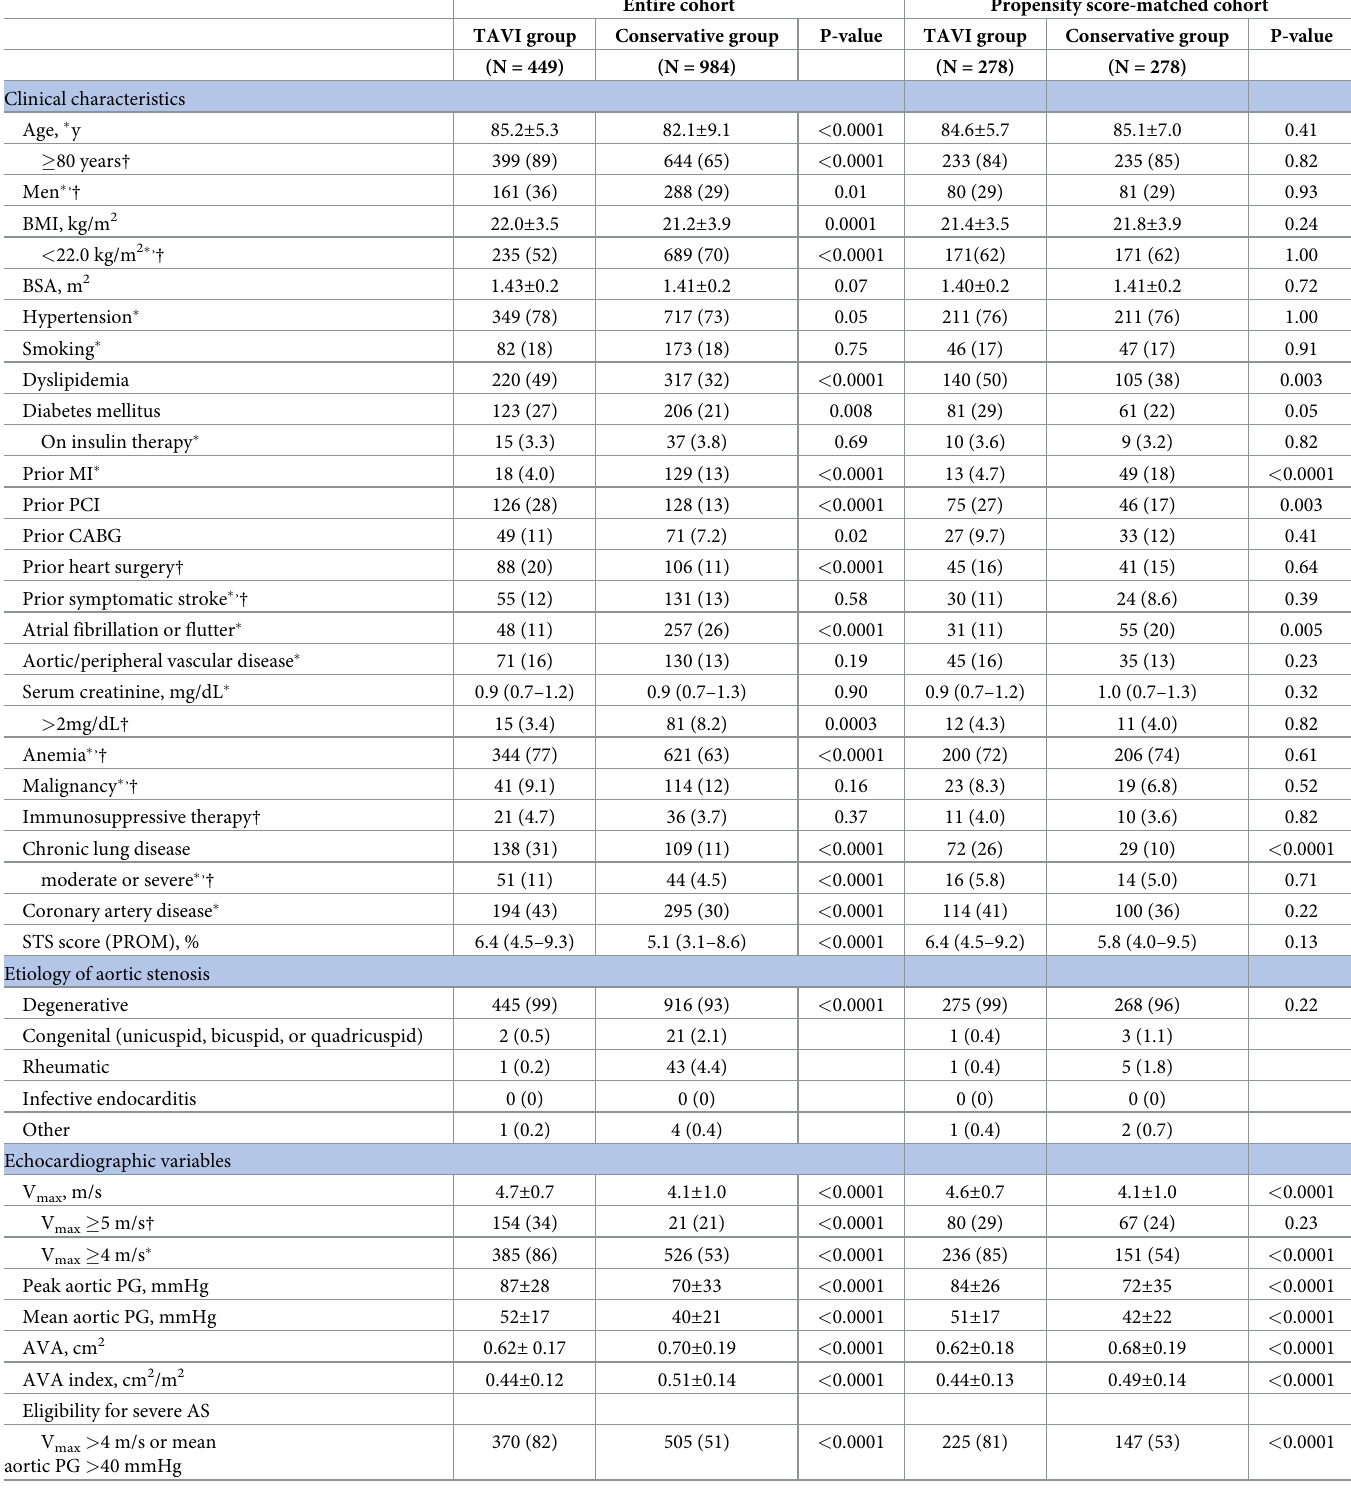
Table 1. Baseline patient